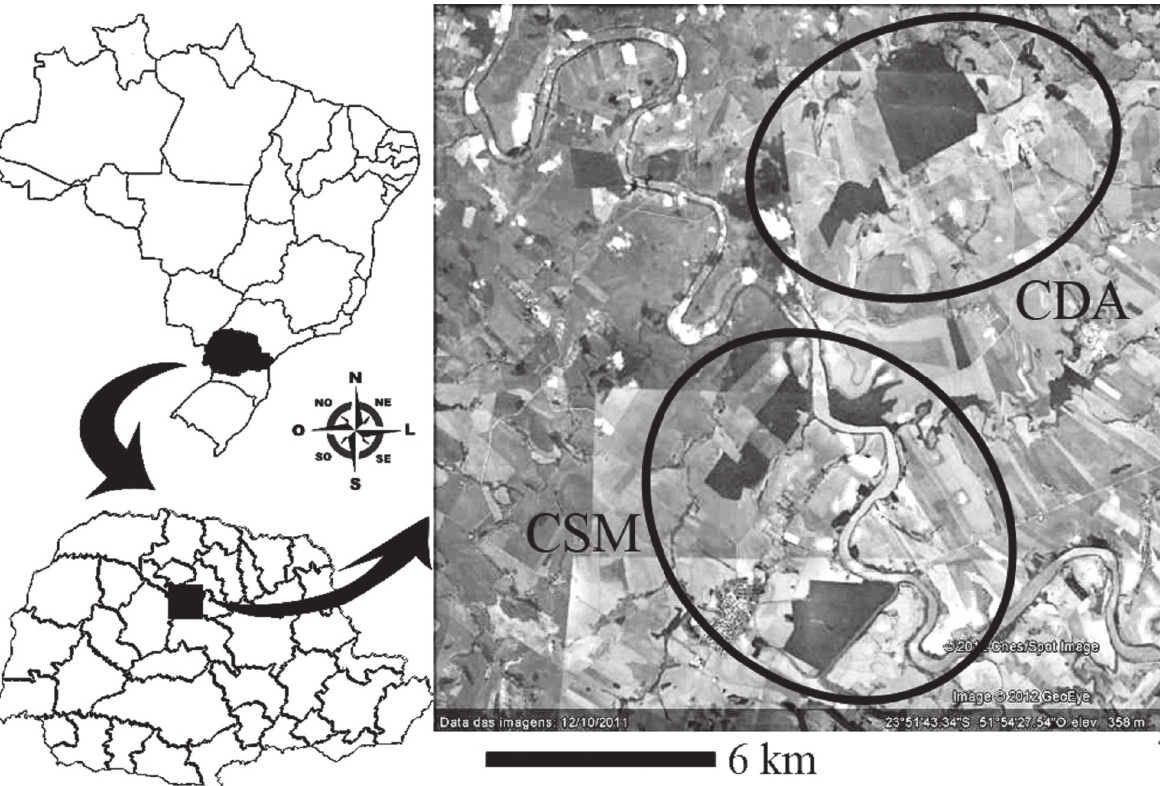
Figure 1 - Map of Brazil, featuring the state of Paraná and a satellite image of both areas sampled between September 2011 and March 2012, demonstrating the fragments of Mesophytic Semideciduous Forest and its surroundings. CDA: Reserve